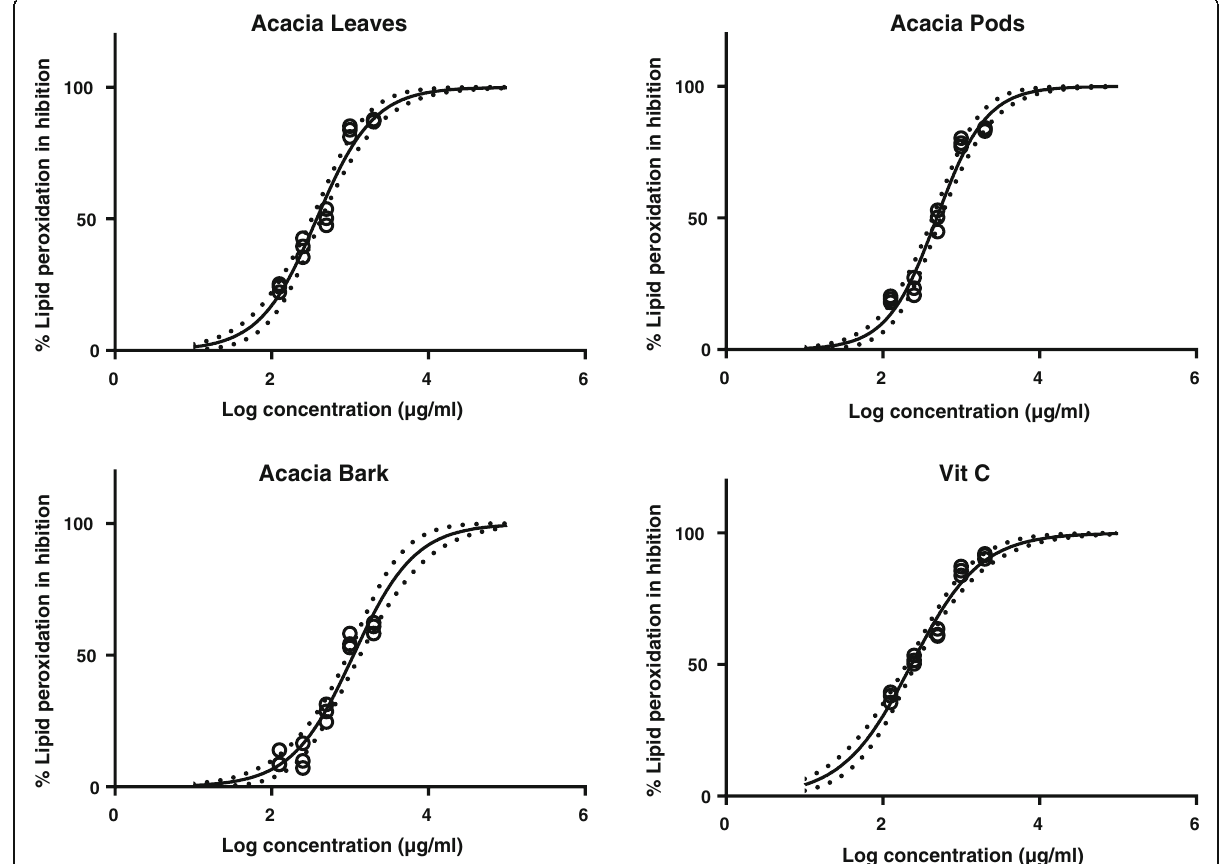
Fig. 2 Estimated lipid peroxidation inhibition of Acacia nilotica extracts (leaves, pods and bark) and ascorbic acid (standard) at different concentrations, using non linear regression. Open circles represent observations, the solid lines represent the estimated mean curves, and the broken lines represent the 95% confidence intervals of the mean estimates